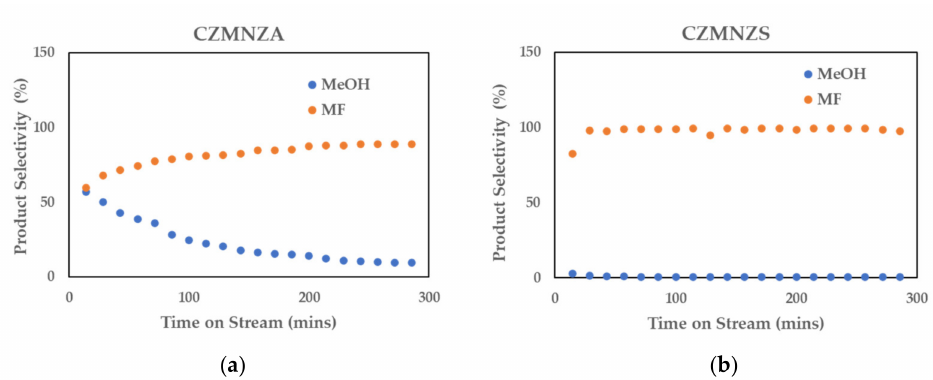
Figure 16. TOS of methanol and methyl formate selectivity for ( a ) CZMNZA ( b ) CZMNZS at reduction temperature 250 ◦ C.